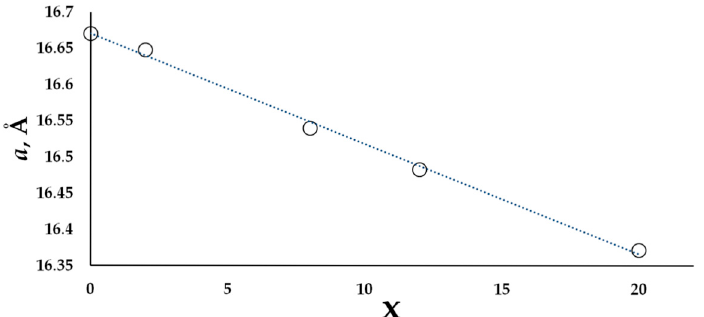
Figure 2. Cubic unit cell parameters vs.x in solid solutions Eu 7 Cu 44- x Ni x As 23 . Markers cover standard deviations.